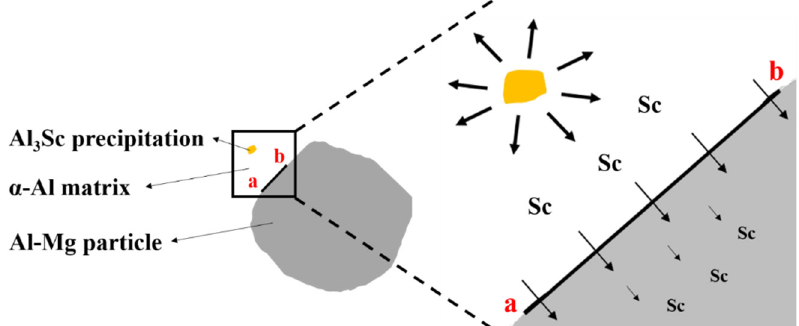
Figure 14. Schematic diagram of atomic diffusion in two-stage-heat-treated SLM Al–Mg–Sc–Zr alloys.